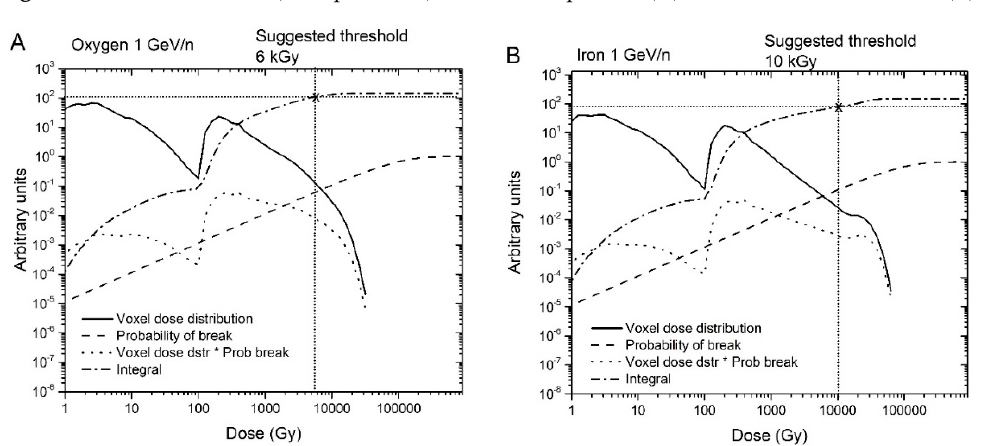
Figure 4. Dose distribution per voxel, probability of at least one break, voxel dose distribution x probability of at least one break, and cumulative integral of the previous quantity for oxygen 1 GeV/n ( A ) and iron 1 GeV/n ( B ). VI.